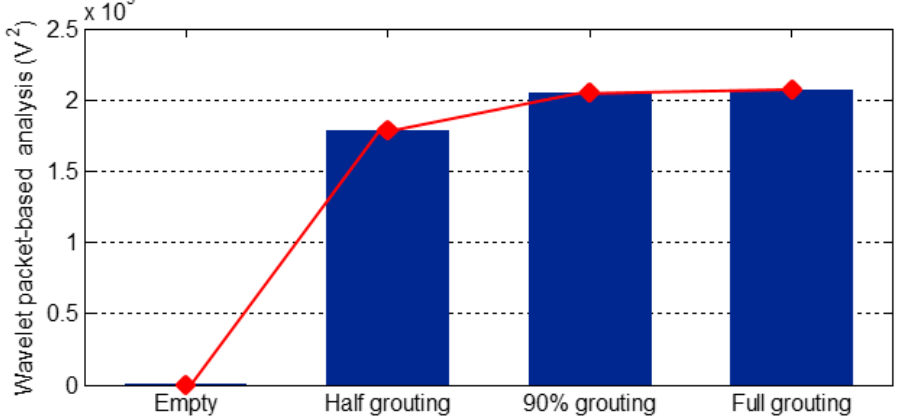
Figure 13. Wavelet packet-based energy analysis of PZT 1 located on the bottom surface.